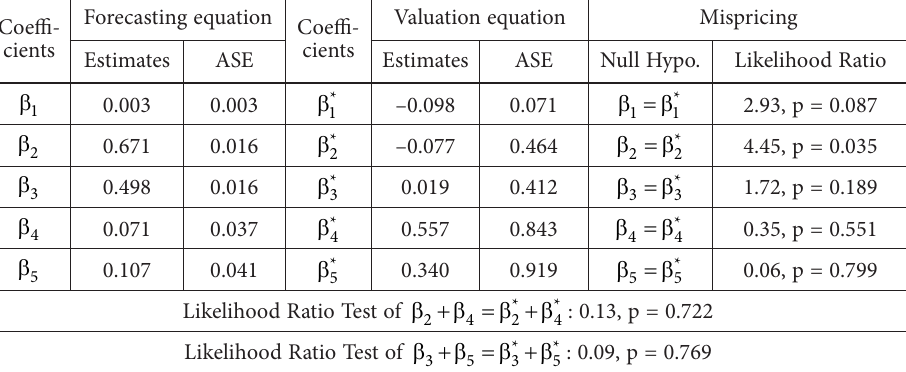
Panel B3: Market pricing tests for the components of earnings from governance activities (G) Coeffi-